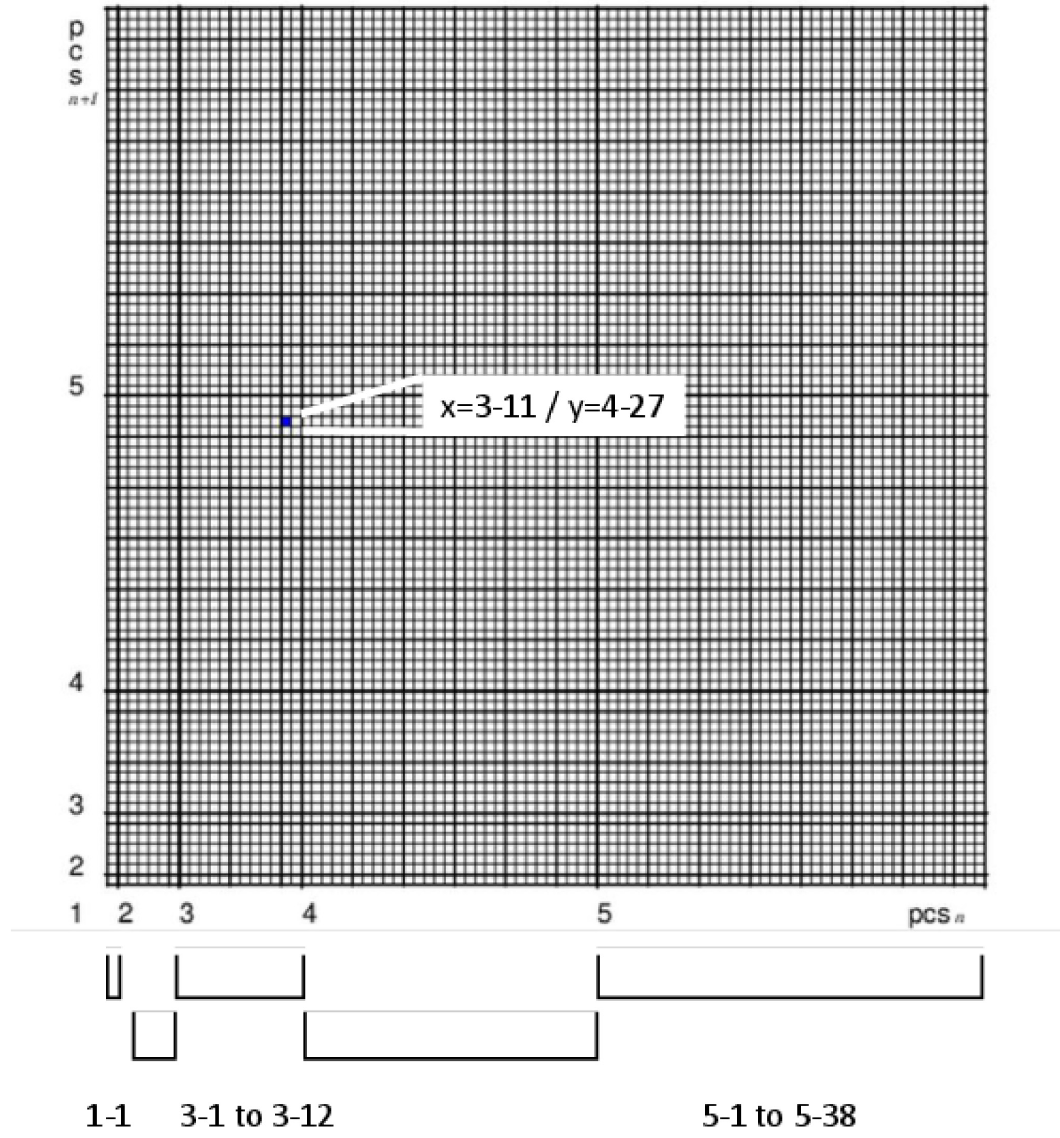
Fig 2. Schematic of creation of a fingerprint grid diagram of pcs n - pcs n+1 2-tuples. [The consecutive pcs (corresponding to chordal links) are coded and plotted as ‘Forte name/numbers’ (i.e. pcs 1–1, 2–1 to 2–6, 3–1 to 3–12 etc.) of the initial pcs n = right hand value (x) and the name/number of the target pcs n+1 = high value